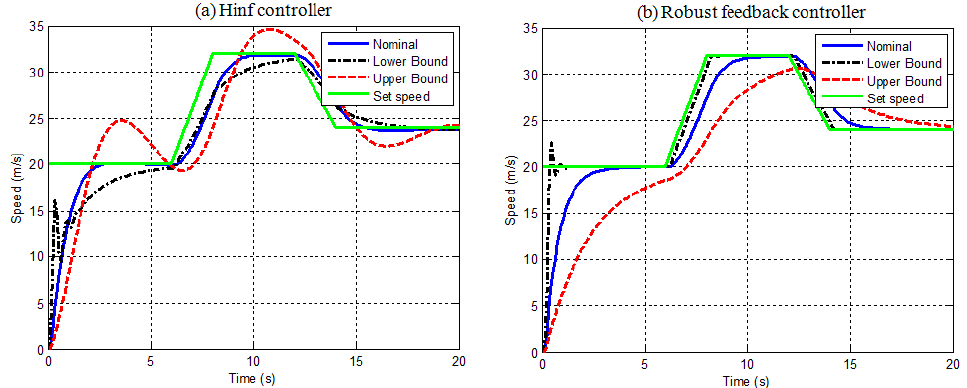
Figure 8. Wide range cruise tracking response for the HEV speed control ( a ) with the 𝐻 ∞ controller and ( b ) with the robust feedback controller